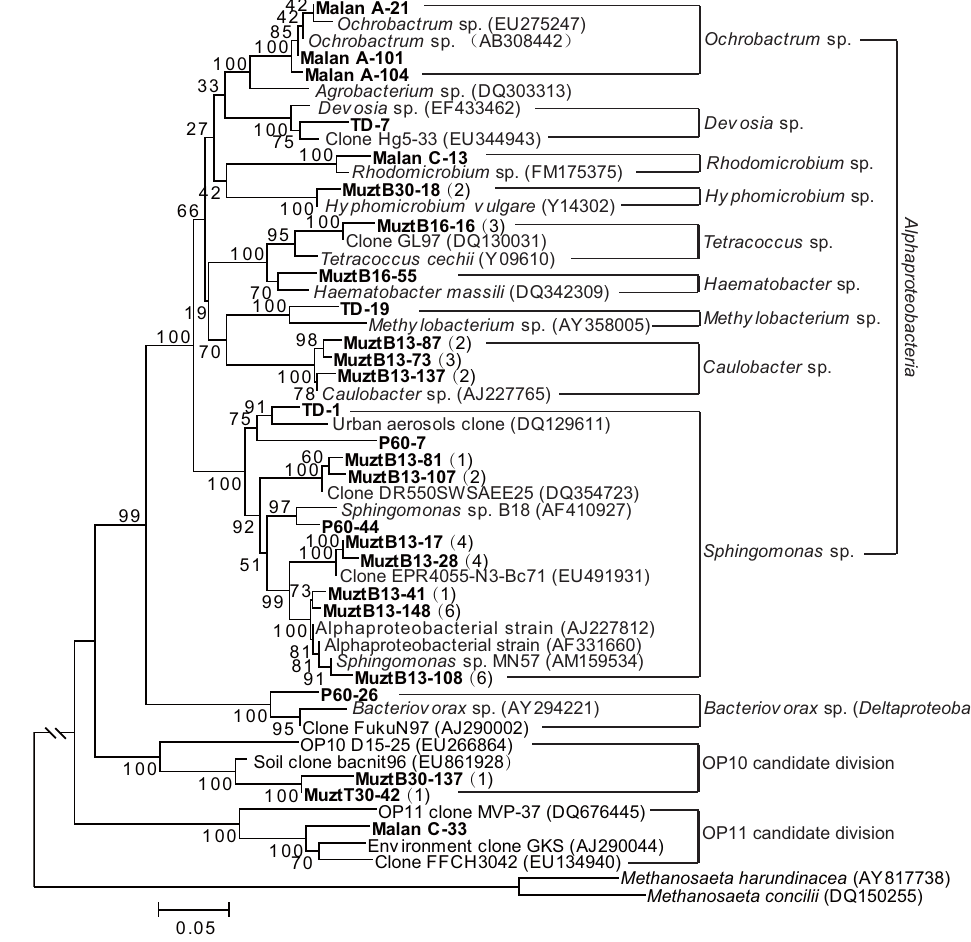
Fig. 3b. Phylogenetic analysis of the 16S rRNA genes for the Alphaproteobacteria , Deltaproteobacteria , OP10 and OP11 clones from the four geographically isolated glaciers and the closest relatives. The tree was constructed by following the protocol as described in Fig. 3a. Scale bar indicated 0.05 substitutions per